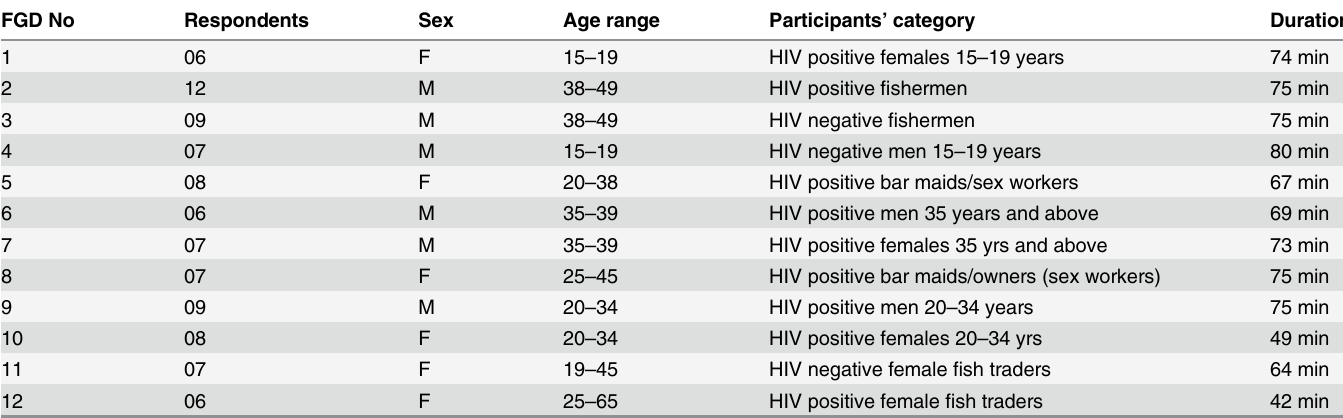
Table 2. General characteristics of FGD participants (n = 92). F Female. M